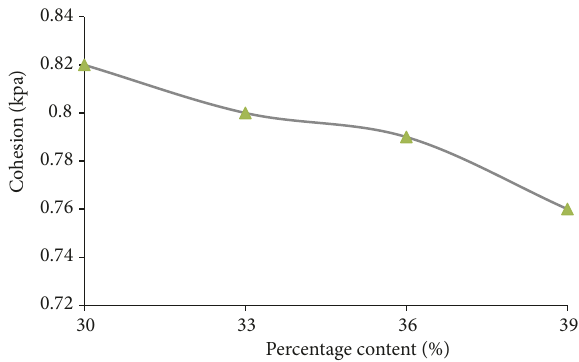
Figure 10: Influence of silt clay on